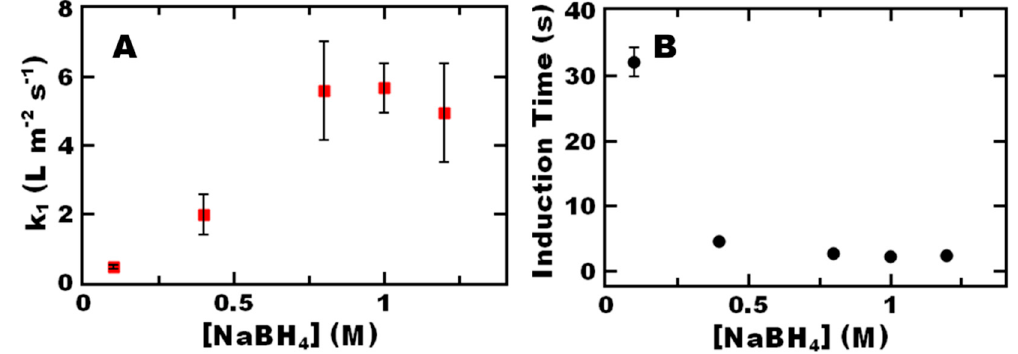
Figure 2. E ff ect of varying concentration of sodium borohydride concentration used in the 4-nitrophenol reduction reaction on ( A ) reaction rate constant and ( B ) induction time using castor oil nanoreactors (CO NRs). The initial concentration of 4-nitrophenol in each reaction was 0.1-mM. A) A plateau in apparent reaction rate constant per surface area of gold ( k 1 ) is observed for CO NR above 0.8-M NaBH 4 concentration. CO NR show a maximum k 1 of 5.7 ± 0.7 L m − 2 s − 1 . B) The CO NR system shows a maximum induction time of 32 ± 2 s.